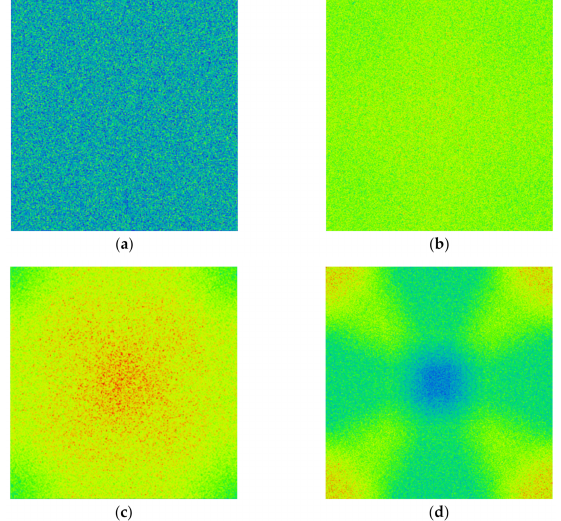
Figure 13. Light spots of different SSRs: ( a ) SSR = 0.25; ( b ) SSR = 1; ( c ) SSR = 3; ( d ) SSR =